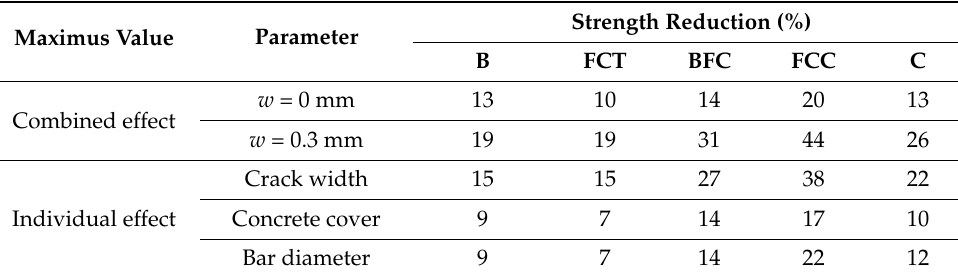
Table 4. Reduction in flexo-compressive strength in 25